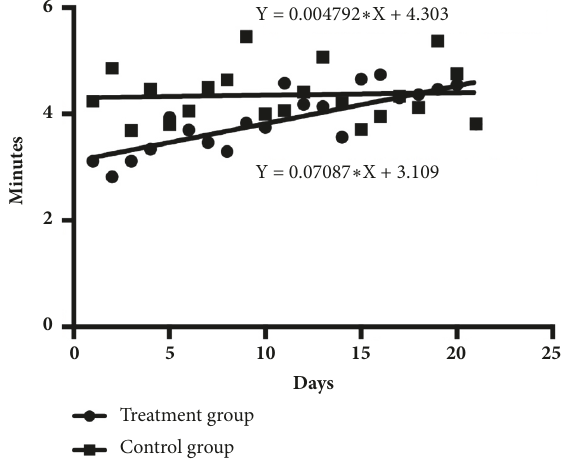
Figure 6: Onset time of the first piglets coming to the sow’s udder to suckle after exposure to the suckling sounds (treatment group) and the control group (not exposed to the AS sound) each day of the lactation